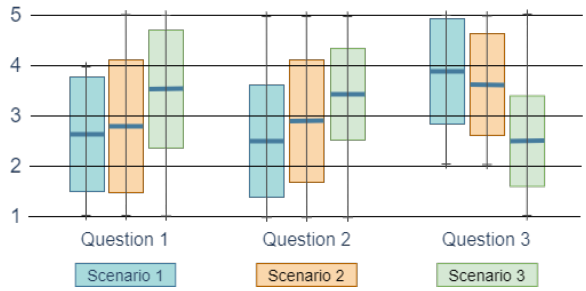
Figure 5. Results of the usability